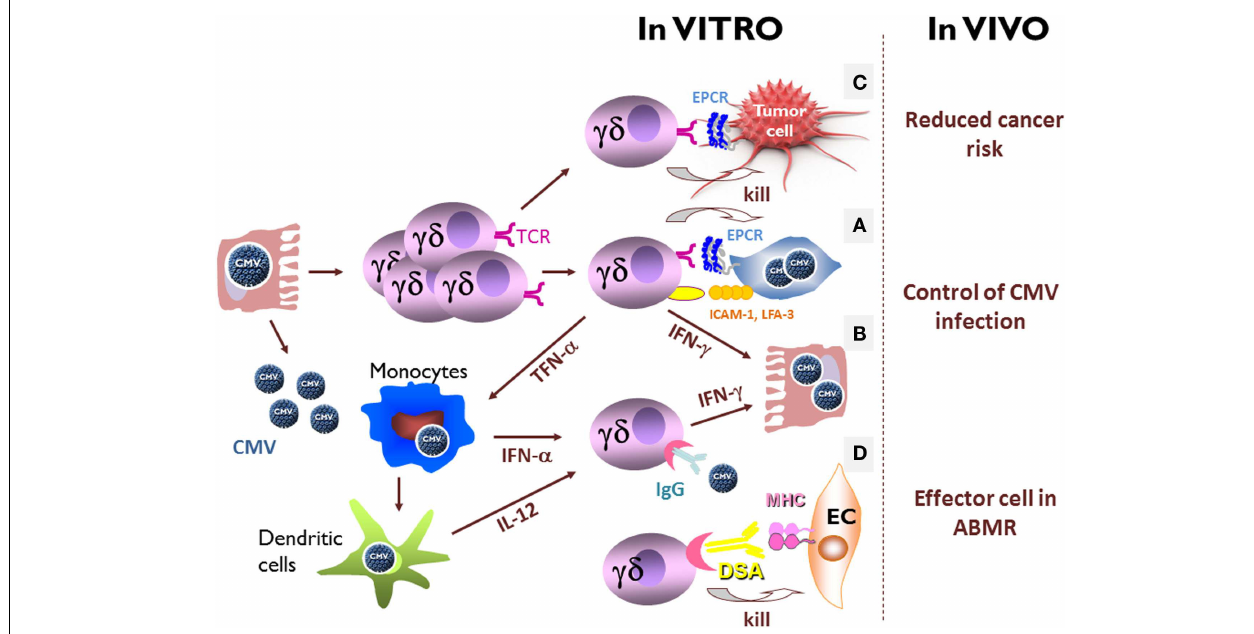
presence of IL-12 and interferon- α , two cytokines produced by monocytes/macrophages and dendritic cells during CMV infection. (C) CMV-inducedV δ 2 neg γδ T cells have aTCR-dependent cross-reactivity against CMV-infected cells and tumor cells. (D) CMV-induced CD16 + V δ 2 neg γδ T cells are able to perform antibody-dependent cell-mediated cytotoxicity (ADCC) against endothelial cells (EC) coated with donor-specific antibody (DSA).Within the grafts, γδ T cells are retrieved in close contact with endothelial cells in the peritubular capillaritis and glomerulitis associated with acute antibody-mediated rejection, only in CMV-experienced